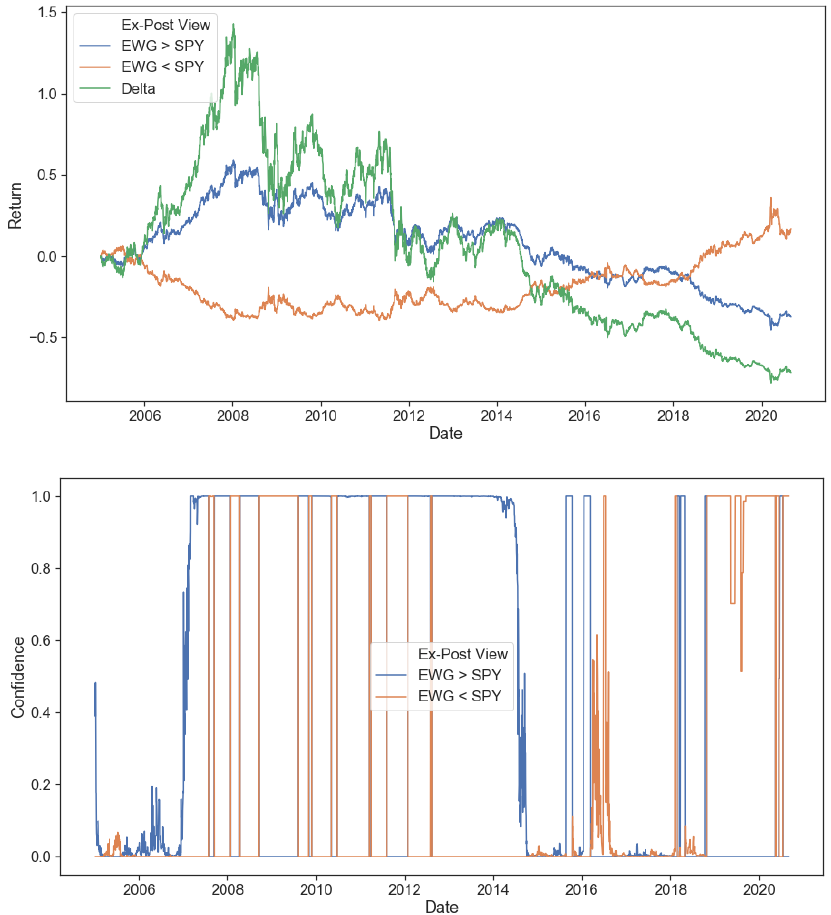
Figure 12. View Returns and Confidence